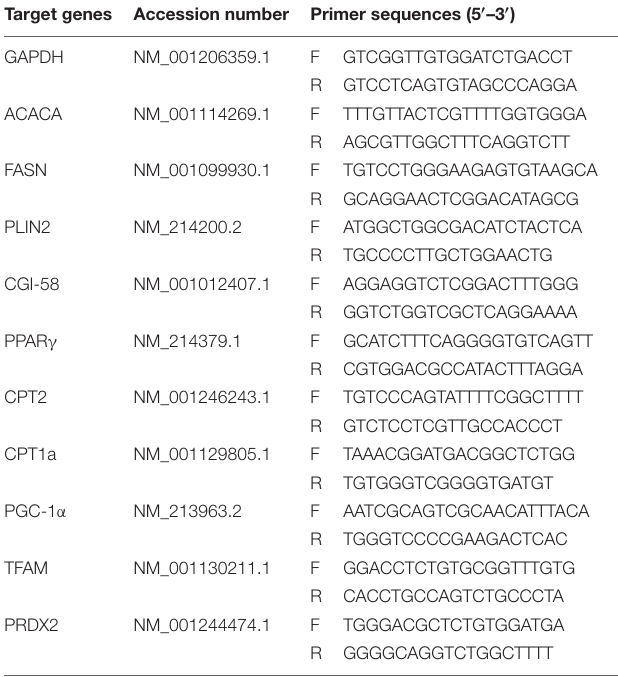
TABLE 1 | The primers used for real-time q-PCR. Target genes Accession number Primer sequences (5 (cid:48) –3 (cid:48) )